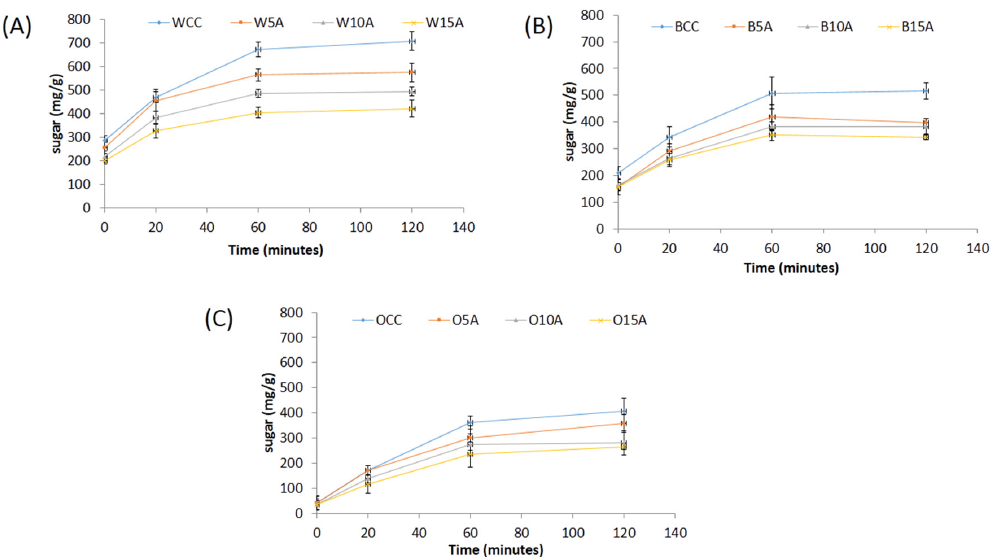
Figure 2. Reducing sugar released (mg/g sample) during the 120 min in vitro digestion process of ( A ) wheat, ( B ) barley and ( C ) oat wholemeal flour cookies with astaxanthin substitution. WCC, wheat cookie control; W5A, wheat + 5% astaxanthin cookie; W10A, wheat + 10% astaxanthin cookie; W15A, wheat + 5% astaxanthin cookie; BCC, barley cookie control; B5A, barley + 5% astaxanthin cookie; B10A, barley + 10% astaxanthin cookie; B15A, barley + 15% astaxanthin cookie; OCC, oat cookie control; O5A, oat + 5% astaxanthin cookie; O10A, oat + 10% astaxanthin cookie; O15A, oat + 15%